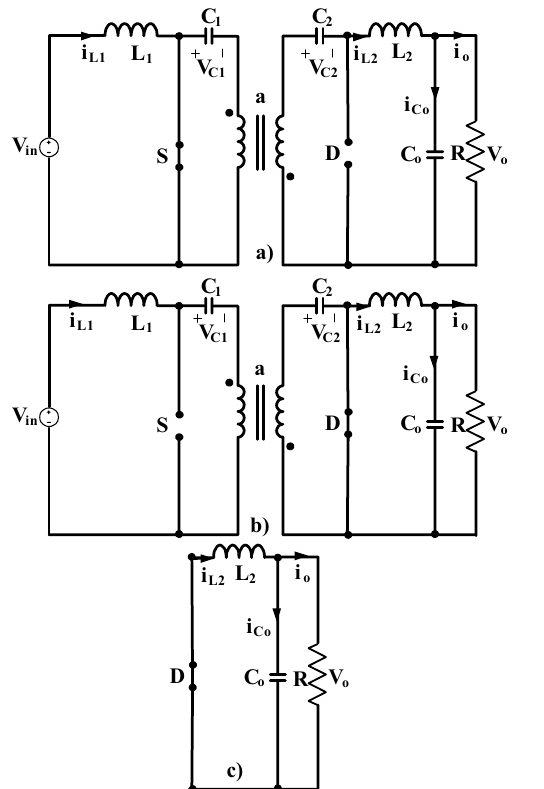
Figure 2. ( a ) Switch on equivalent circuit ( b , c ) switch off equivalent circuits of isolated PFC Ćuk